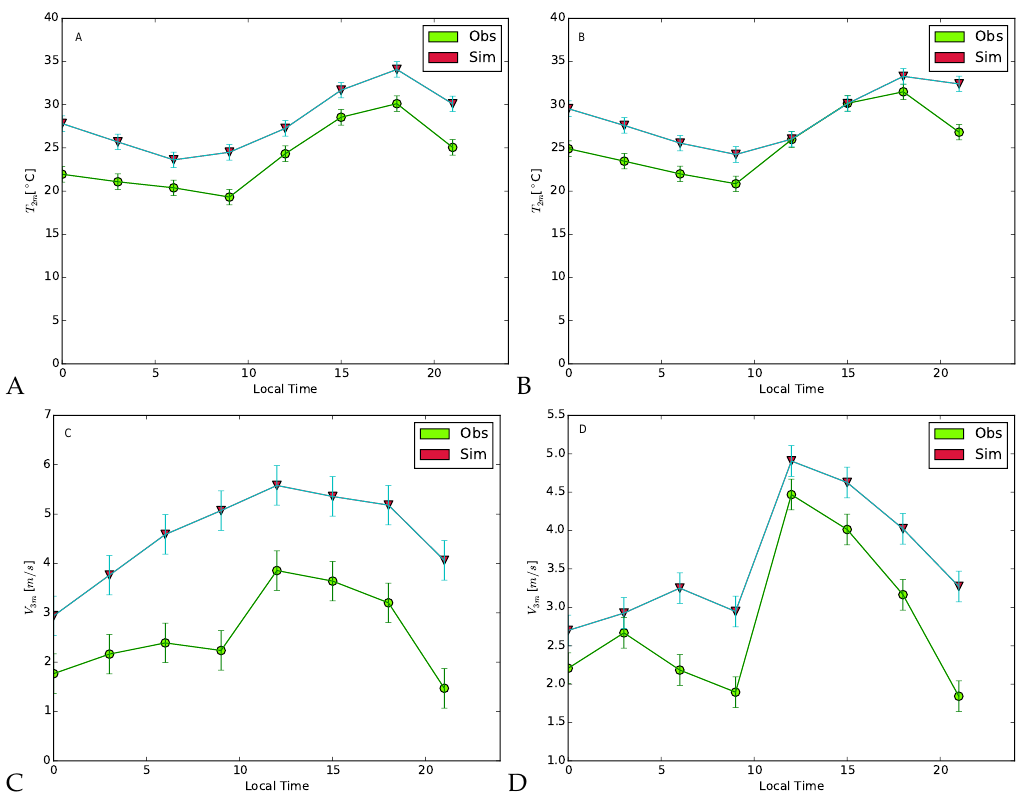
Figure 3. Average diurnal cycles of observed and simulated ( A , B ) 2m air temperatures ( T 2 m ) and ( C , D ) 3m wind speeds ( V 3 m ) for ( A , C ) 1 April–31 May 1998 (Araripina/PE station) and ( B , D